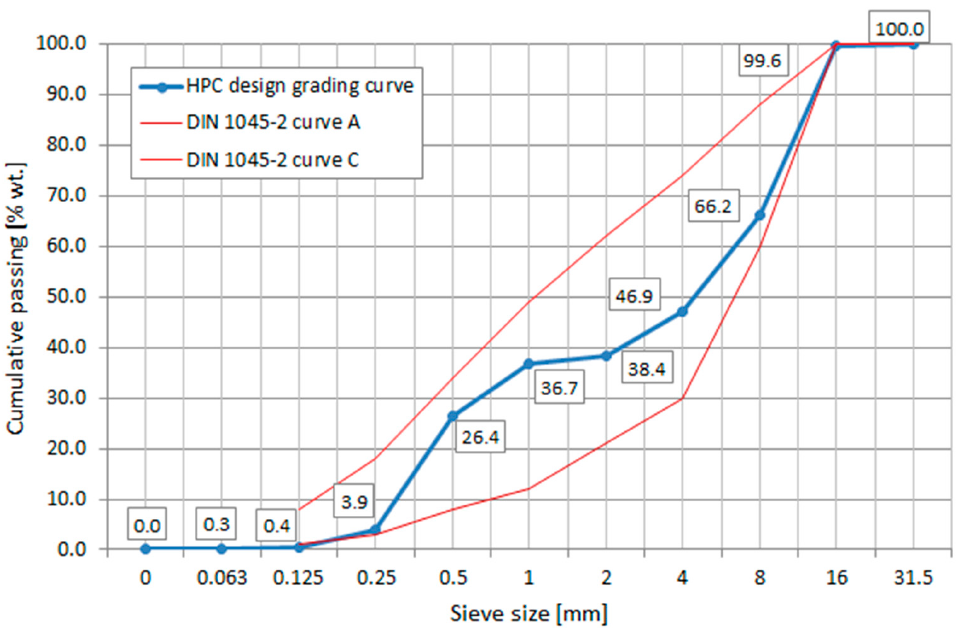
Figure 1. HPC grading curve with target DIN 1045-2 grading.